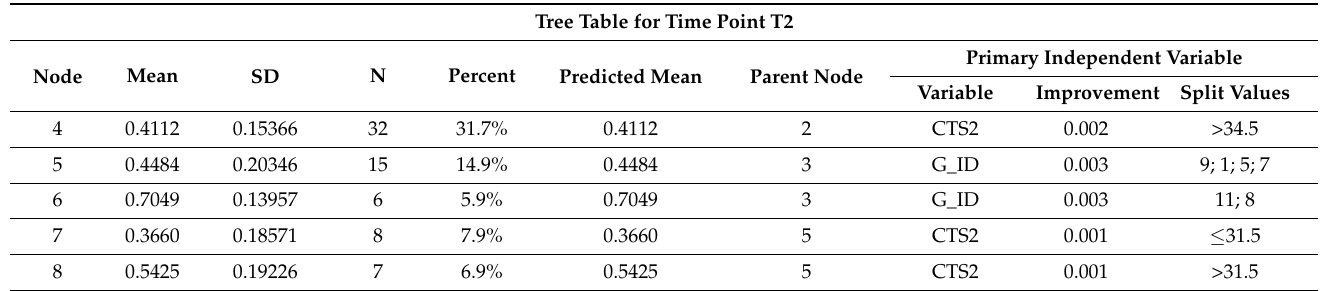
Table A4. Cont. Tree Table for Time Point T2